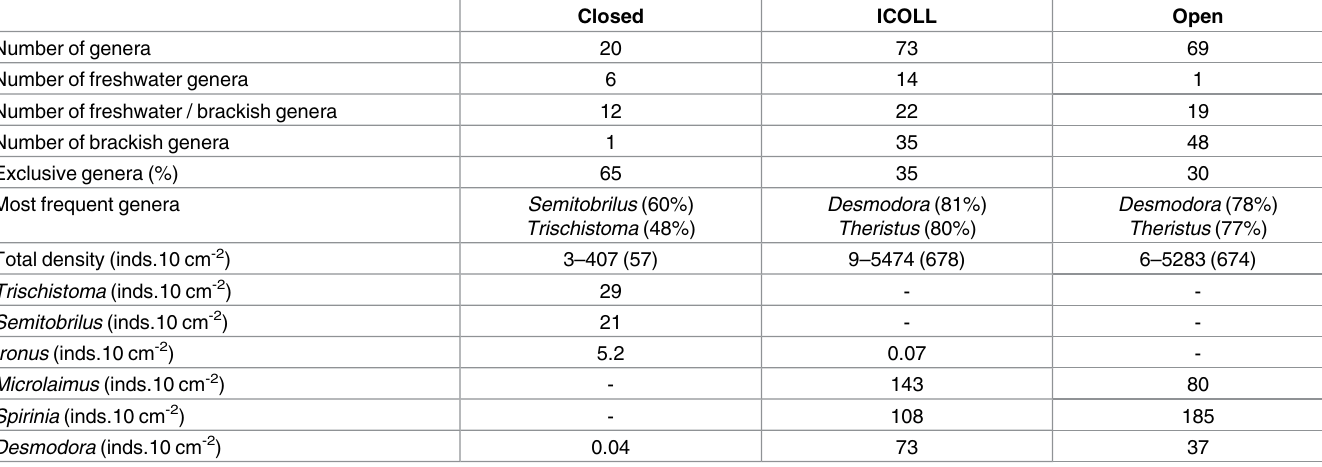
Table 1. Summarycharacteristics of nematode assemblages from coastal